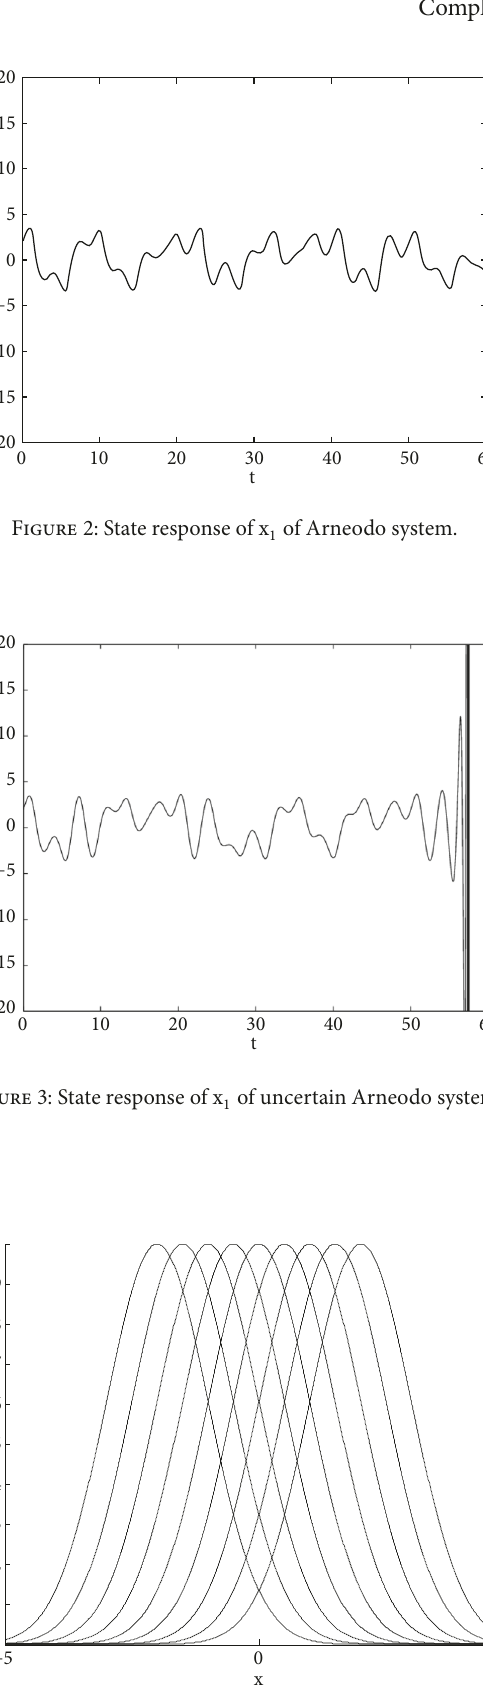
Figure 4: Fuzzy membership